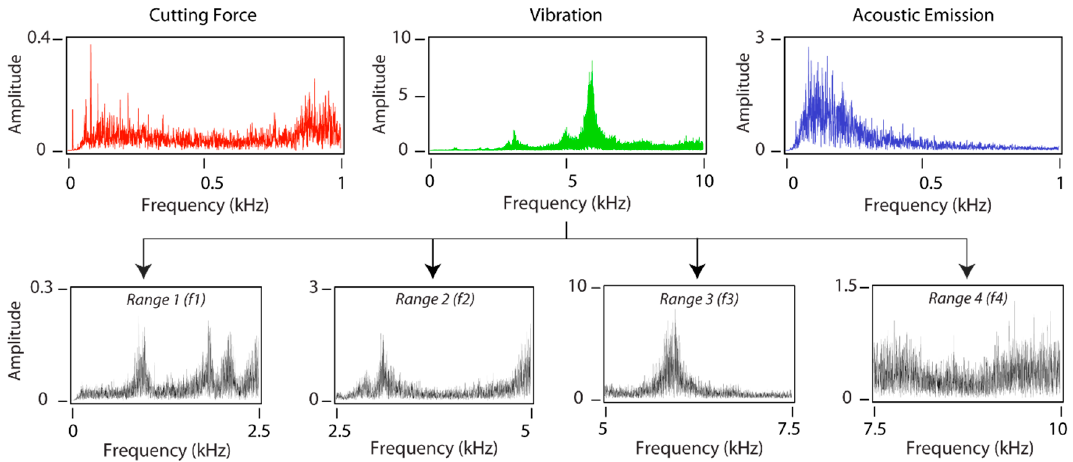
Figure 6. PSD signal processing method with four frequency ranges.